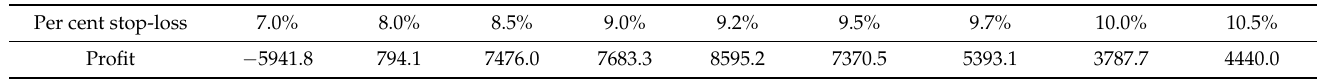
Figure 10. Profit dependency on the predefined stop-loss limit. Source: Authors’ processing is based on the results obtained in Figure 9. Table 1. Nonlinear variation of total profit is based on the pre-imposed stop-loss limit.